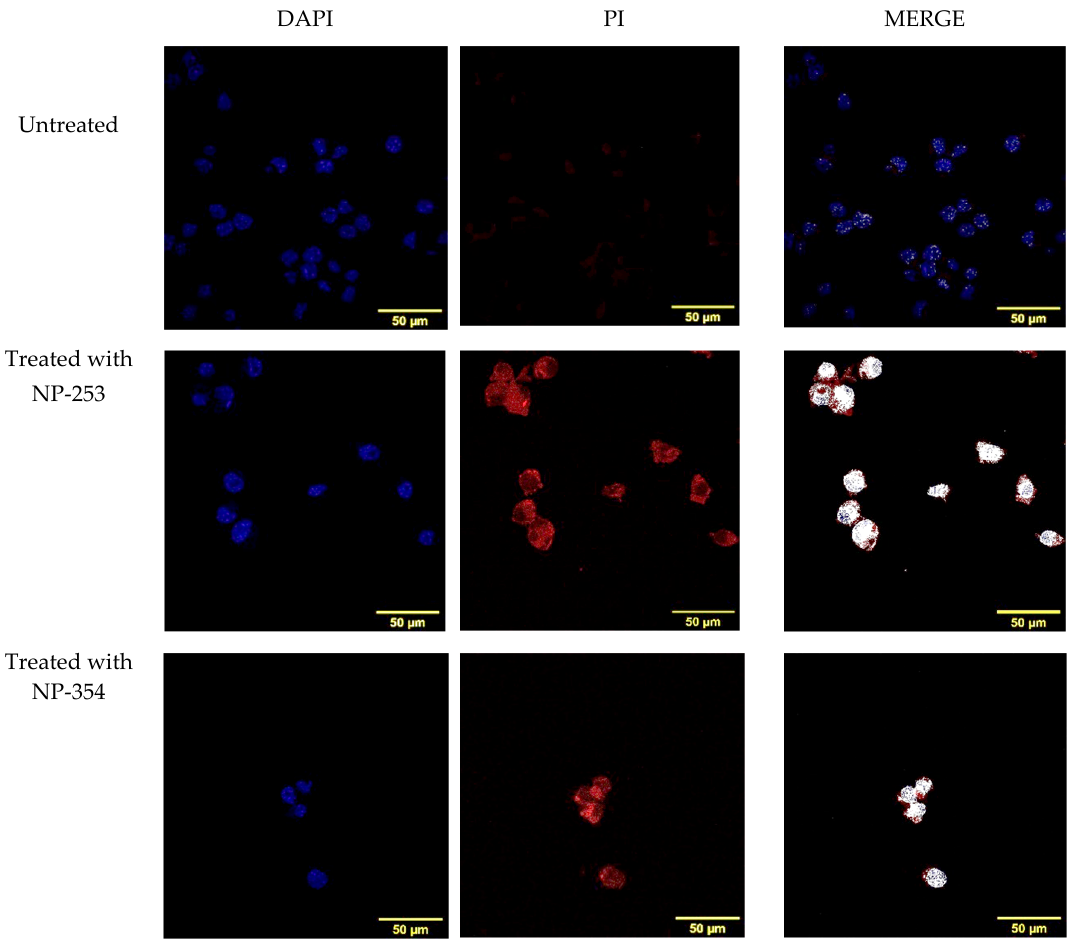
Figure 10. Induction of cell death in LLC cells by NP-253 and NP-354 confirmed by nuclear PI staining. Immunofluorescence of untreated LLC cells (upper panel) shows no co-localization of nuclear DNA dye DAPI (blue) with the cell death (late apoptosis) marker propidium iodide (PI, red), as shown in the upper right panel (merge, white). LLC cells treated 6 h with either NP-253 (middle panel) or NP-354 (lower panel) show co-localization of DAPI and PI (right panels, white color shows co-localization), suggesting compromised membranes and entry of PI inside the nucleus.